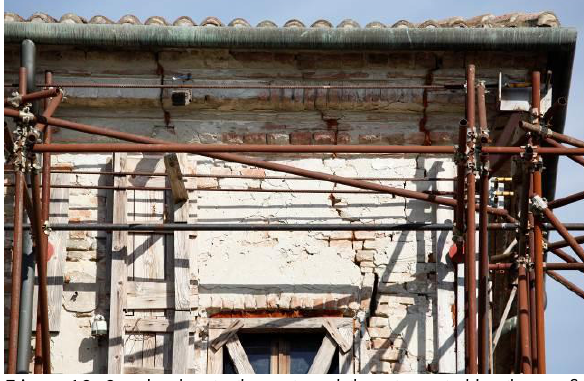
Figure 12: Cracks due to the outward thrust exerted by the roof.